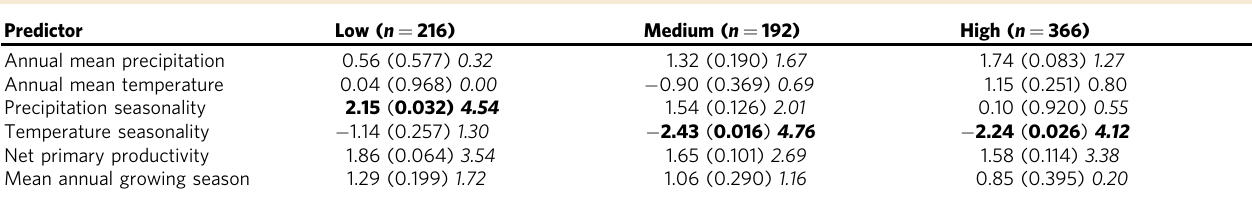
Table 1 Climatic effects on language diversity